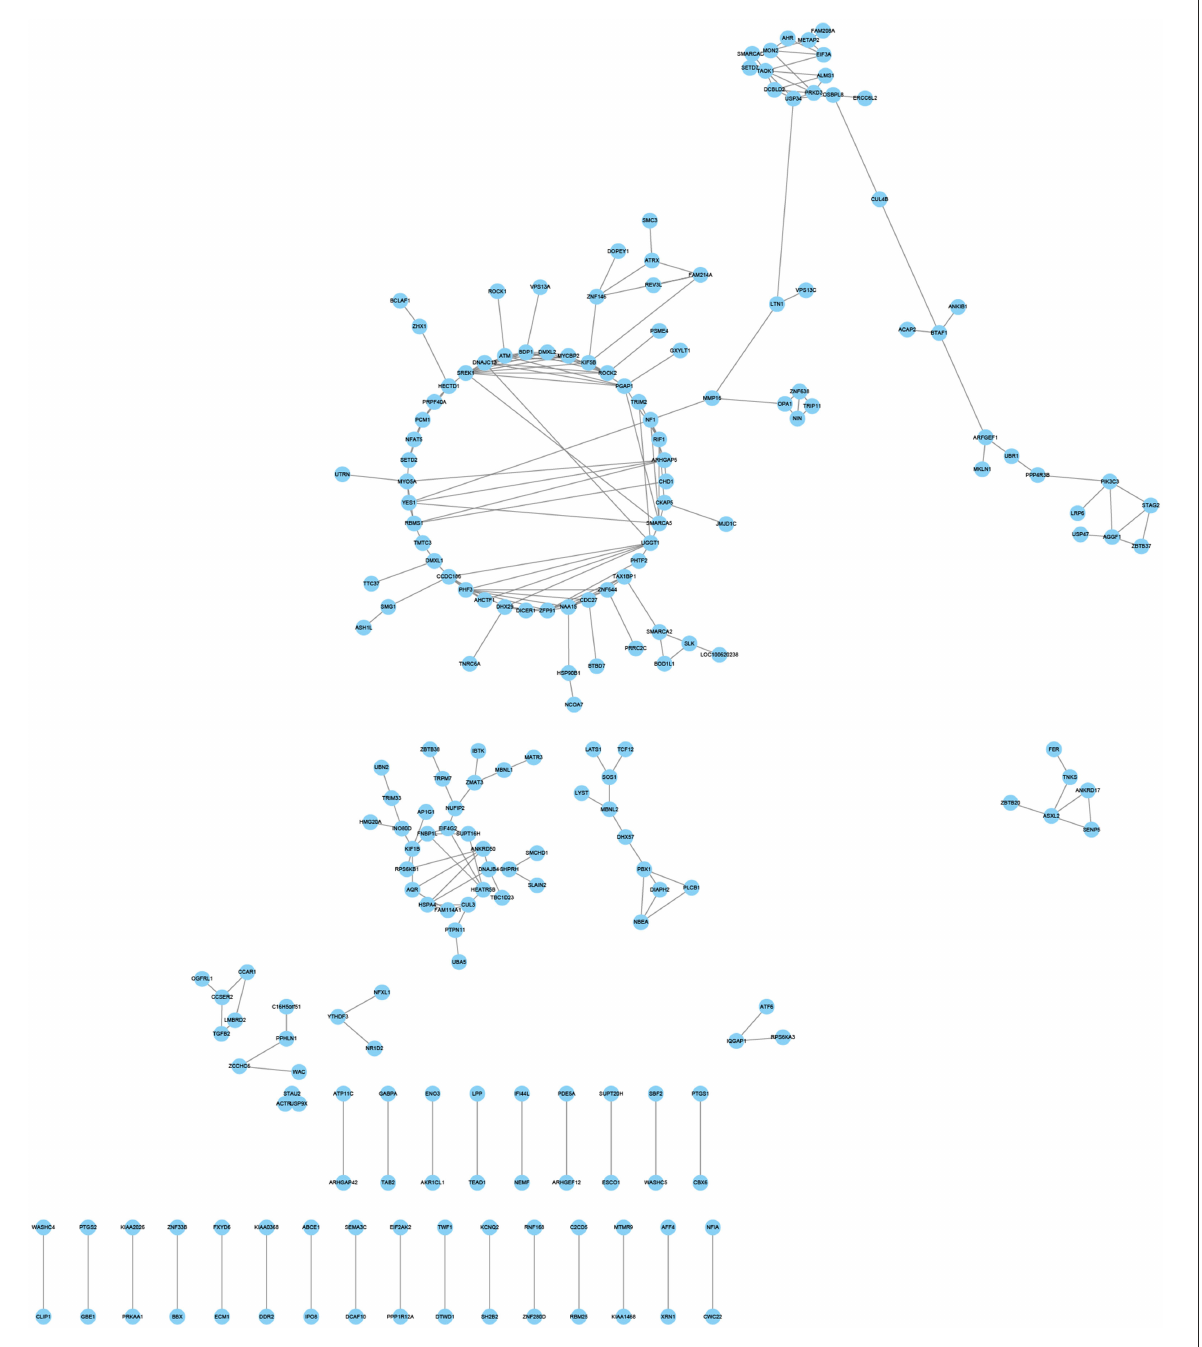
FIGURE6 Coexpression network analyses of alternatively spliced DEGs between normoxic (TN and LN) and hypoxic (TL and LL) groups.